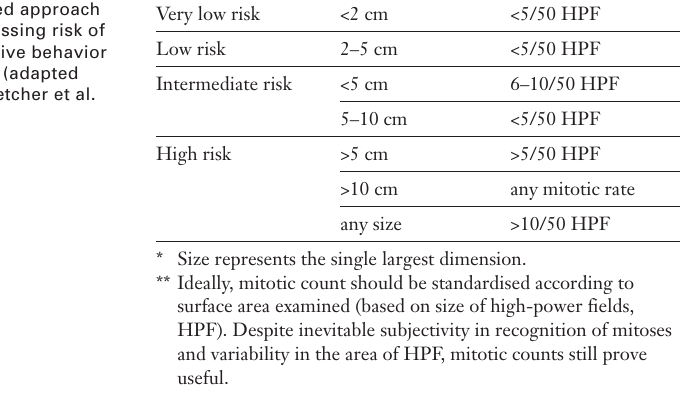
Proposed classifi- cation of GIST according to malignant potential (adapted from Bucher et al.